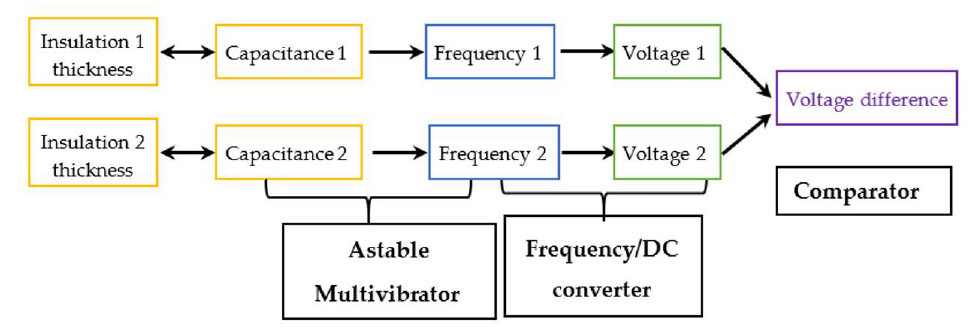
Figure 7. Illustration of the process measurement principle.